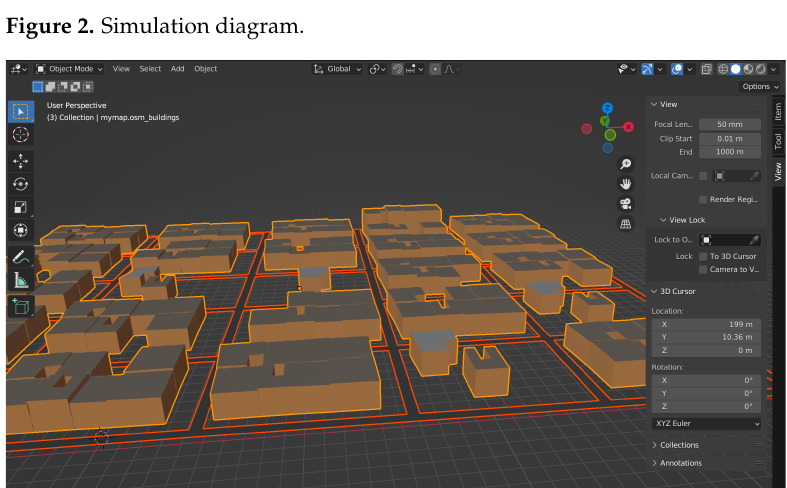
Figure 3. Three-dimensional map of the